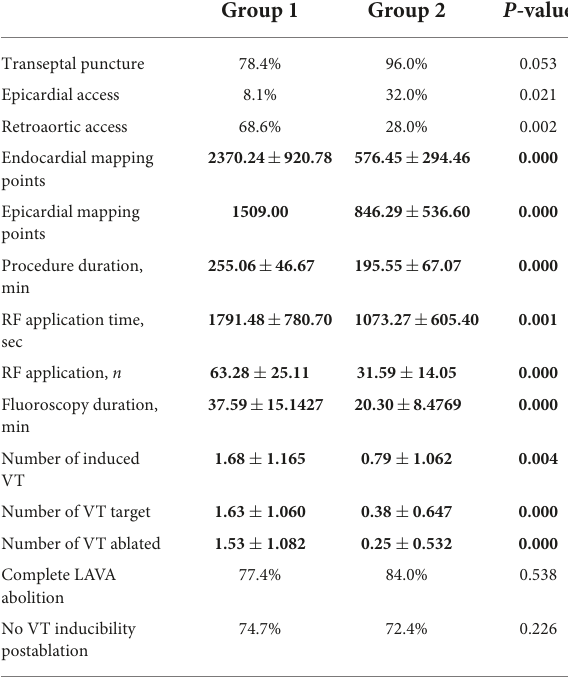
TABLE 2 Procedural